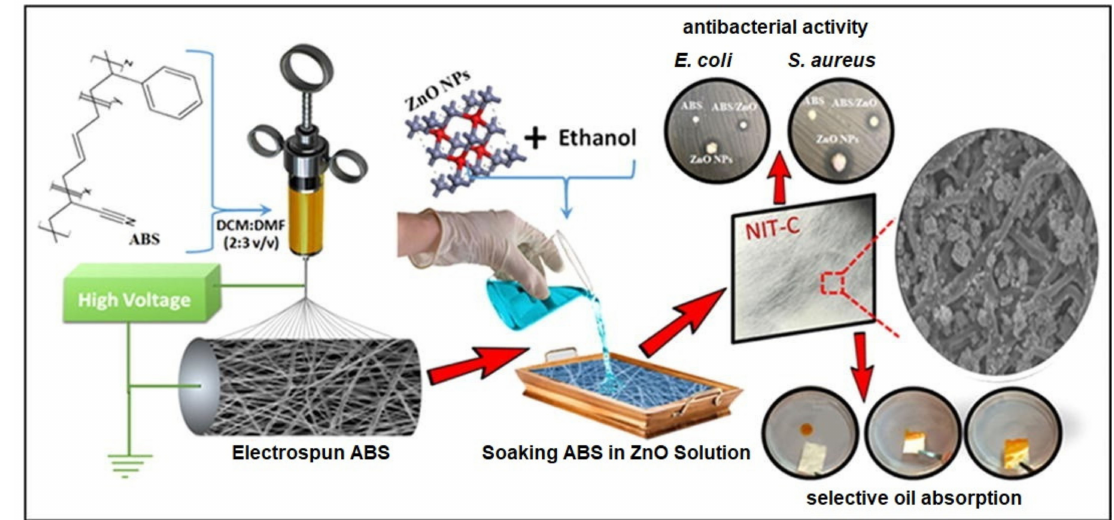
Figure 7. Illustration of the fabrication of ZnO-ABS composite nanofibers membrane with antimicrobial properties tested against E. coli , S. Aureus and selective oil absorption . Reprinted from [88] with permission from